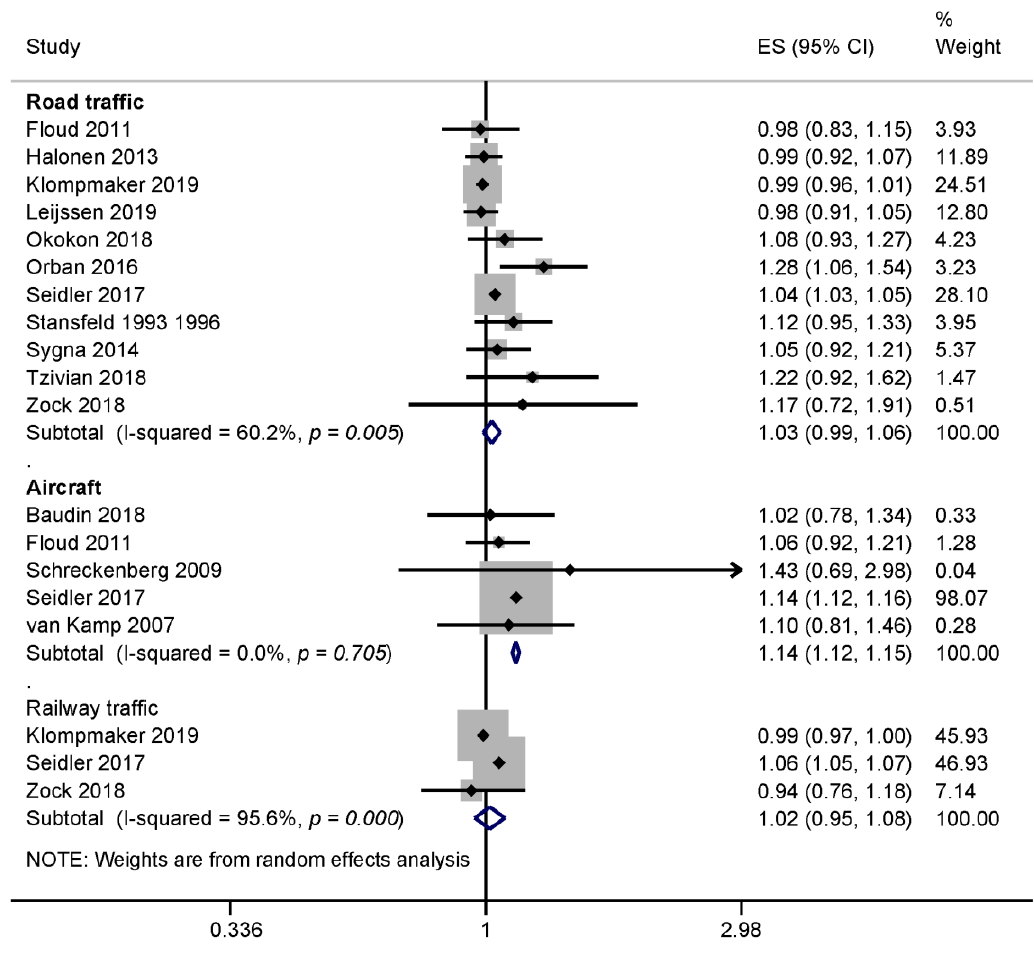
Figure 2. Forest plots of various noise sources and the estimates of effect size (ES) for depression (based on anti-depressant use, depressive episodes diagnoses, detected with validated a screening instrument). All ES were converted to represent the risk per 10 dB L DEN .